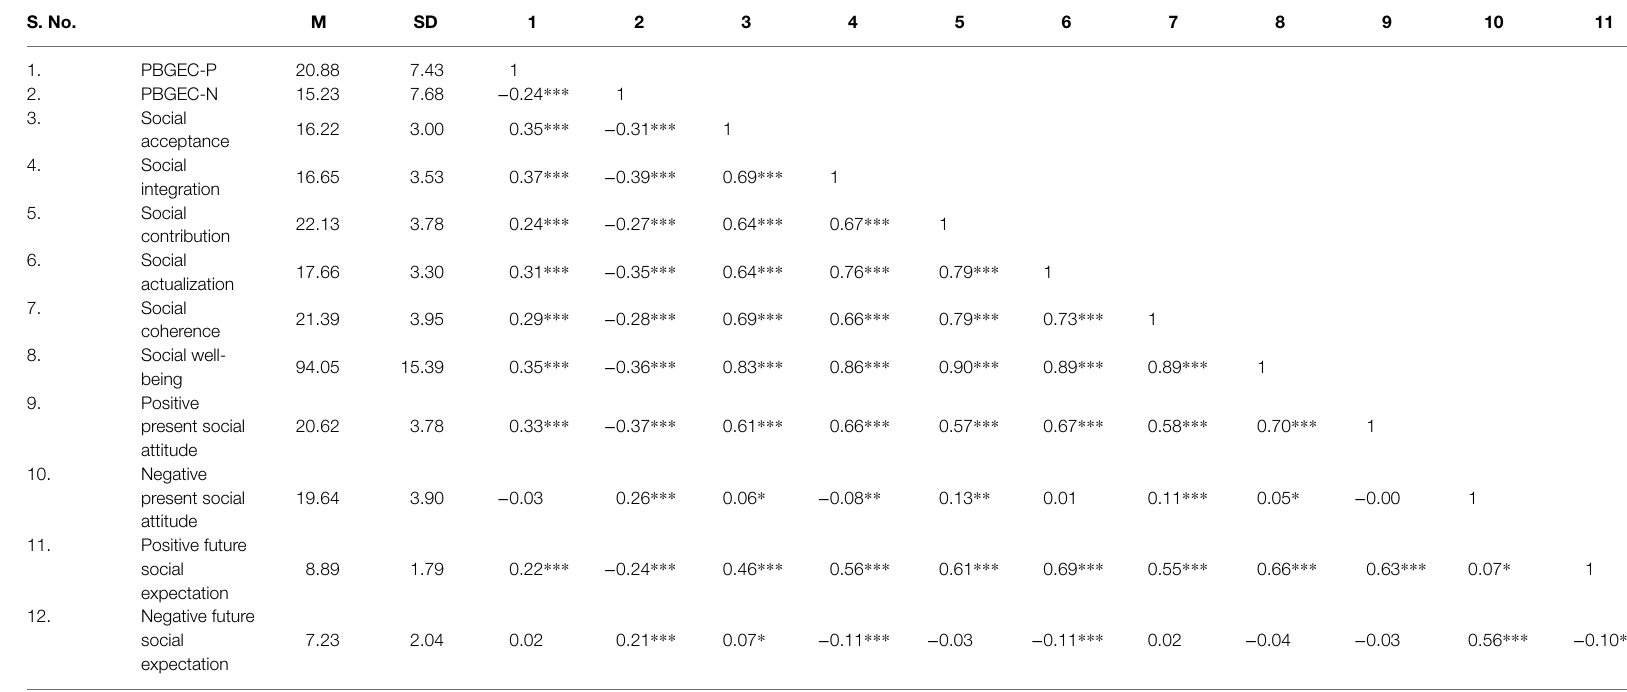
TABLE 7 | Correlations of the PBGECS with present social attitude, future social expectations, social well-being. S.